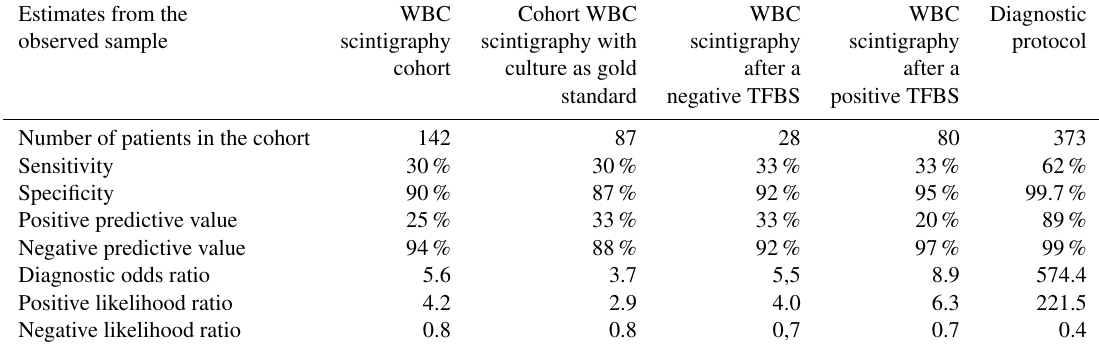
Table 3. Diagnostic accuracy of TPBS stratified for different cohorts for time of onset of initial symptoms after index surgery. Estimates from the observed sample Complete < 2yr > 2yr > 2yr > 5yr Time of onset of symptoms after index surgery cohort THA only TKA only Number of patients in the cohort 340 Number of patients with increased uptake on bone scan 119 Sensitivity 71% Specificity Positive predictive value Negative predictive value if a PJI is clearly excluded 98% Diagnostic odds ratio Positive likelihood ratio Negative likelihood ratio